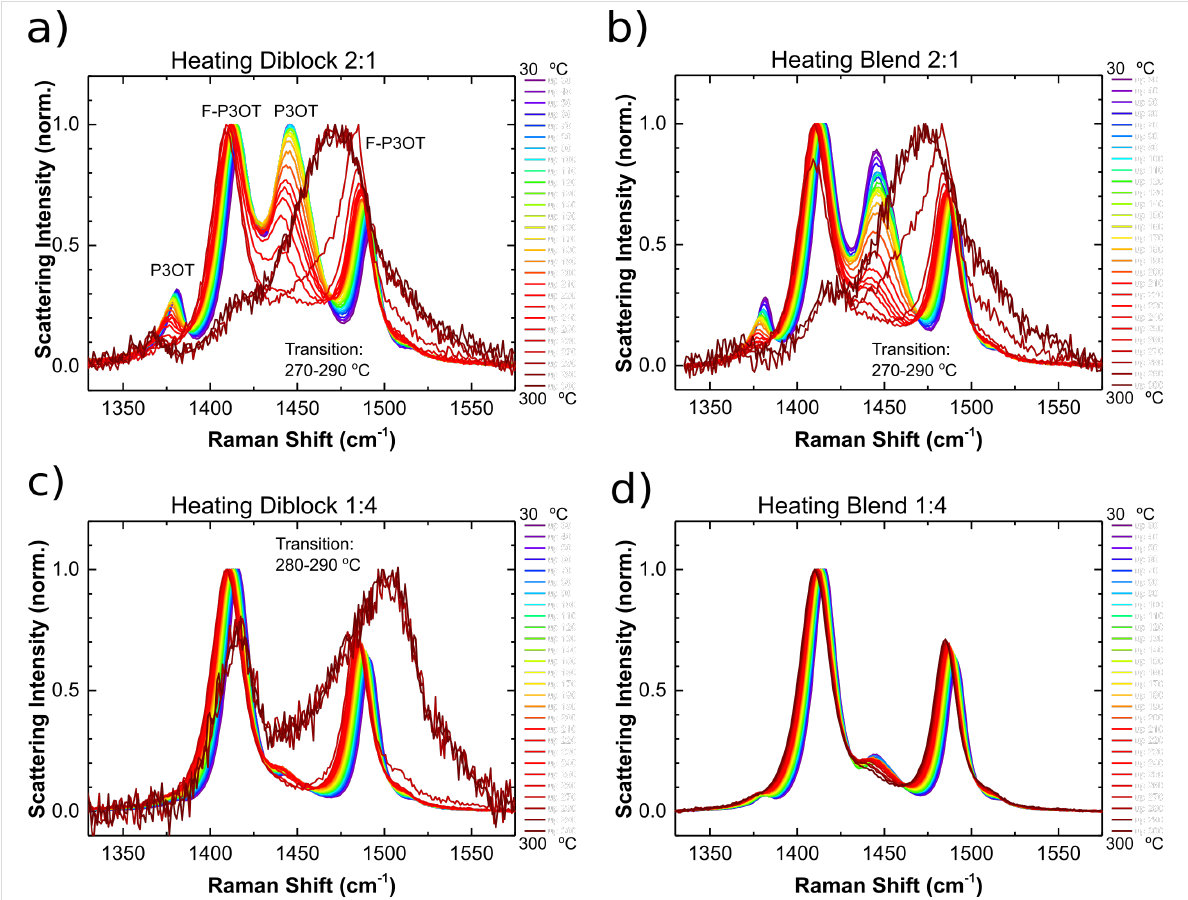
Figure 6: Temperature dependent Raman spectra measured during heating showing the main C–C and C=C stretches of a) P3OT- b -F-P3OT 2:1, b) P3OT/F-P3OT blend in a 2:1 ratio, c) P3OT- b -F-P3OT 4:1, and d) P3OT/F-P3OT blend in a 4:1 ratio. The main peaks are assigned to the fluorinated (F-P3OT) and nonfluorinated (P3OT) segments in a) based on the homopolymer spectra